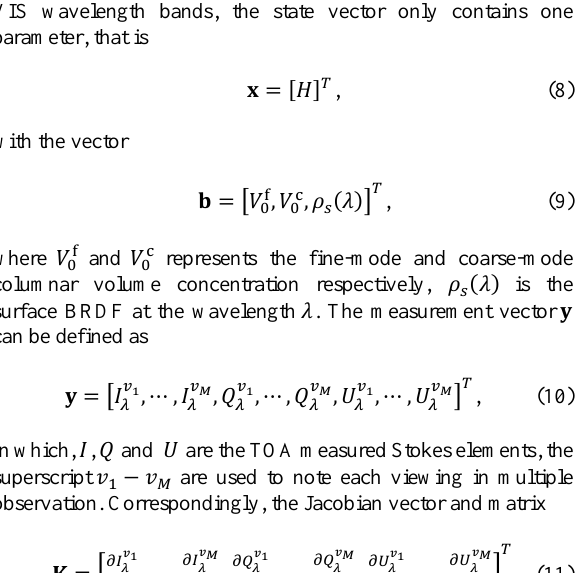
Figure 5. The angular distribution of TOA normalized radiance (a) and normalized polarized radiance (b) in 410 nm with vegetated surface and AOD = 0.8 at 550